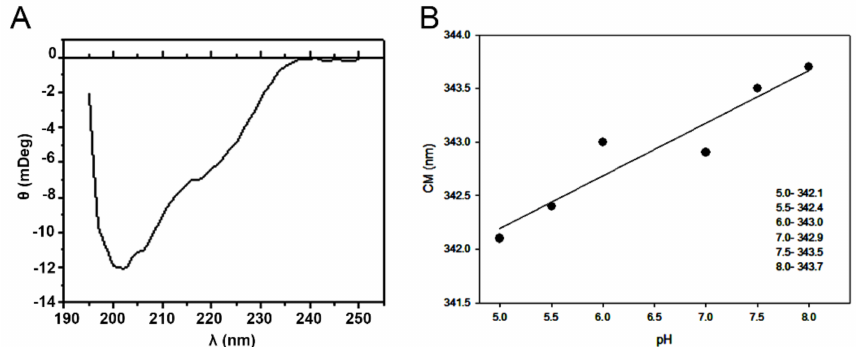
Figure 2. Circular dichroism analysis of the Lmr-47 ( A ) and intrinsic fluorescence spectra on varying pH ( B ). CD spectra of Lmr-47 at 1 mg/mL were recorded at pH 7.5 in 50 mM Tris–HCl at 25 ◦ C. Experiments of IF were performed in 100 mM sodium citrate (pH 5.0 and 5.5), 100 mM phosphate buffer (pH 6.0 and 6.5), and 100 mM Tris–HCl (pH 7.0–8.0) with 0.2 mg/mL of Lmr-47 at 25 ◦ C. Samples were excited at 280 nm, and fluorescence emission was measured between 300 and 400